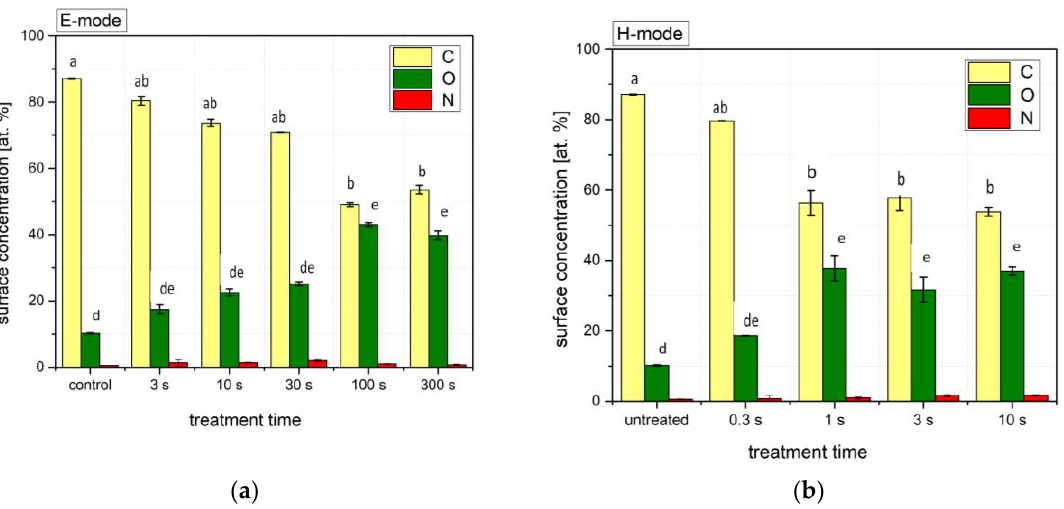
Figure 2. The elemental concentration of wheat seed surface of carbon, oxygen, and nitrogen determined by XPS after treatment with ( a ) E-mode or ( b ) H-mode plasma. The error bars represent standard error. Different lowercase letters above the bars represent statistically significant differences ( p < 0.05; post hoc Tukey’s range tests) between treatments for each individual element (C or O). Mean values (±SE) for the respective duplicates are given.